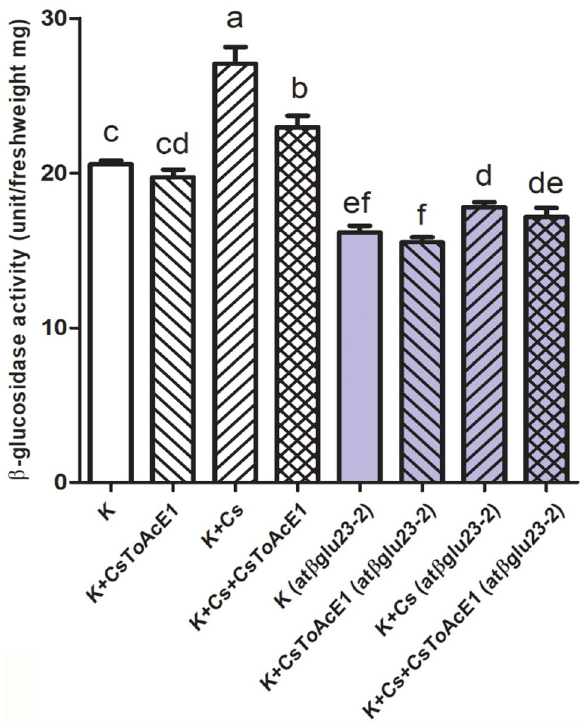
Figure 6. Analysis of β-glucosidase activity. The β-glucosidase activity of wild-type and atβglu23- 2 mutant Arabidopsis plants to CsToAcE1 under Cs-stress (K plus Cs plus CsToAcE1) and non-stress (K plus CsToAcE1) conditions. Plants were grown for 8 days on agar media containing 0.5 mM KCl as a control (K) and media containing 0.3 mM CsCl (+ Cs) with or without the addition of 25 µM CsToAcE1 (+ CsToAcE1). Arabidopsis plants were grown for 8 days on agar media containing 0.5 mM KCl as a control (K) and on agar media containing 0.3 mM CsCl (+ Cs) with or without the addition of 25 µM CsToAcE1 (+ CsToAcE1). The assay kit utilized 4-nitrophenyl-β-d-glucopyranoside as a substrate. Enzyme activity was assessed by monitoring the change in OD 420 in a spectrophotometer for 3 h. One unit of enzyme was calculated based on catalysing the hydrolysis of 1 µmole of β -NPG per min at pH7.0. Data represent the mean ± SE (n = 3). Different letters indicate significant differences ( p < 0.05) between treatments determined by a one-way ANOVA followed by a Bonferroni’s multiple comparisons test.